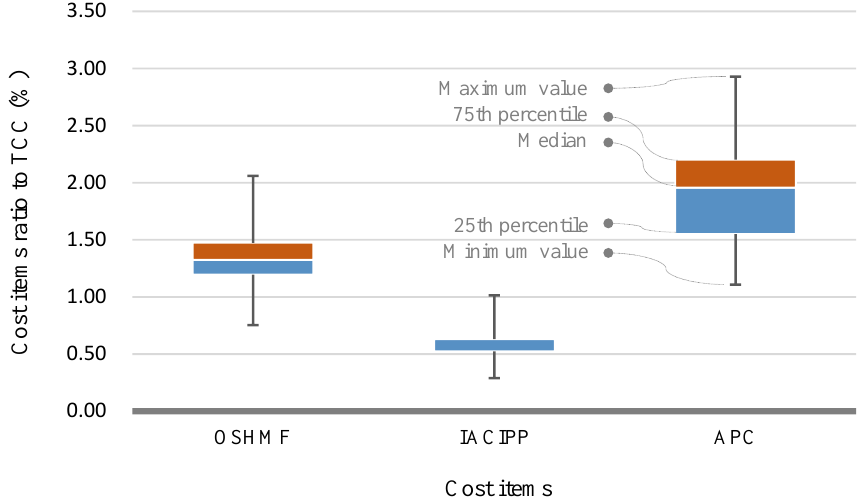
0.005.00 C M2 Figure 3. Properties of major variables in multiple regression equations. Figure 3. Properties of major variables in multiple regression equations.